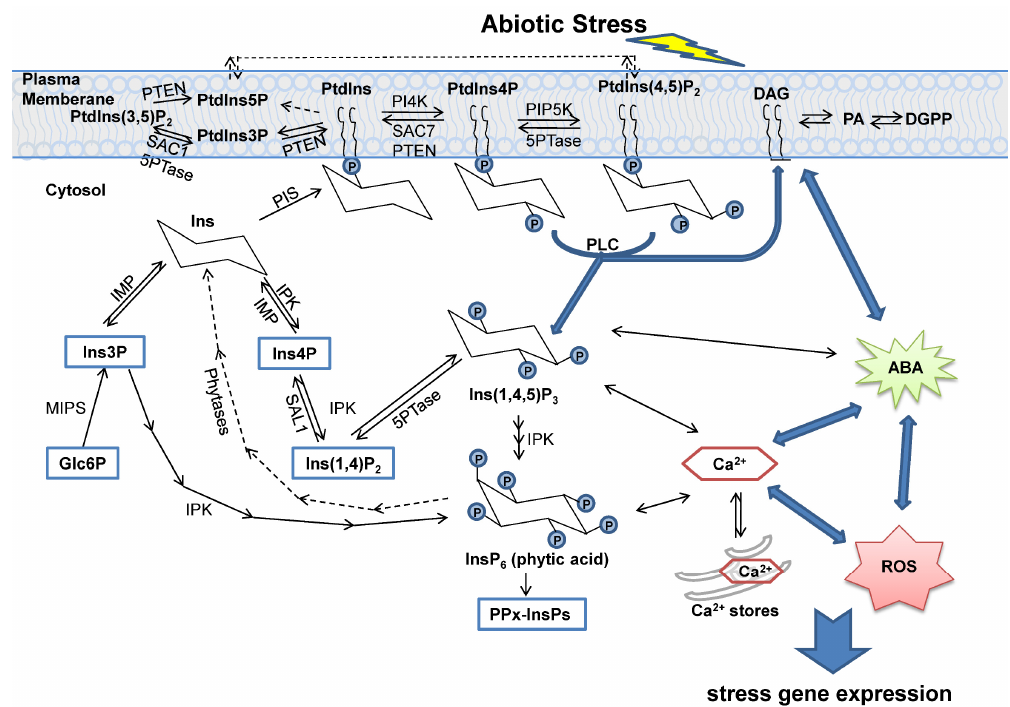
Figure 1. Schematic representation of inositol phosphatases in the plant inositol (Ins) signaling pathways under stress. It illustrated the network of the inositol phosphate (IP) and phosphoinositide (PI) signaling pathway, together with the stress responding processes, such as the ABA pathway, Ca 2 + release, and ROS generation. The dashed arrows indicated the putative